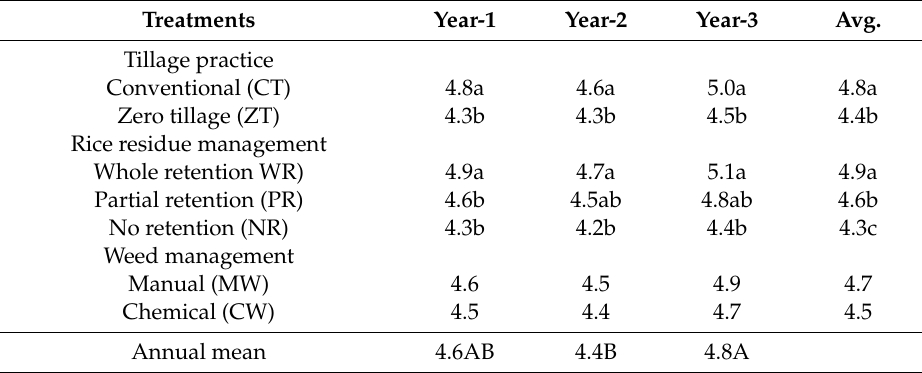
Table 6. Grain yield of rice (t ha − 1 ) under di ff erent tillage, crop residue and weeding management practices. Di ff erent lowercase letters within a column indicate significant di ff erence with a treatment. Di ff erent uppercase letter within a row for annual mean values (last row) indicate significant di ff